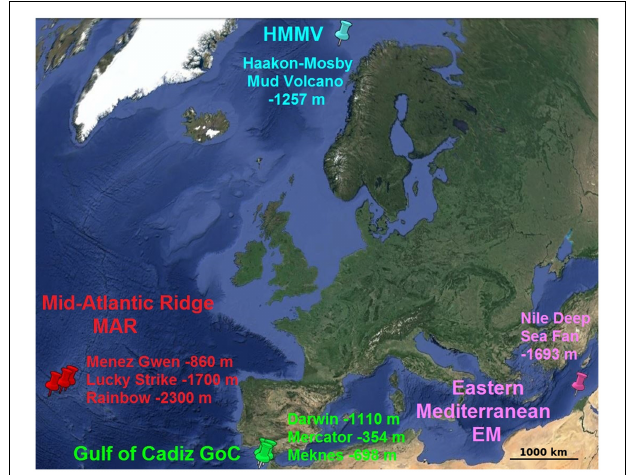
FIGURE 1 | Map of sampling sites and their depths, located in 4 geographical